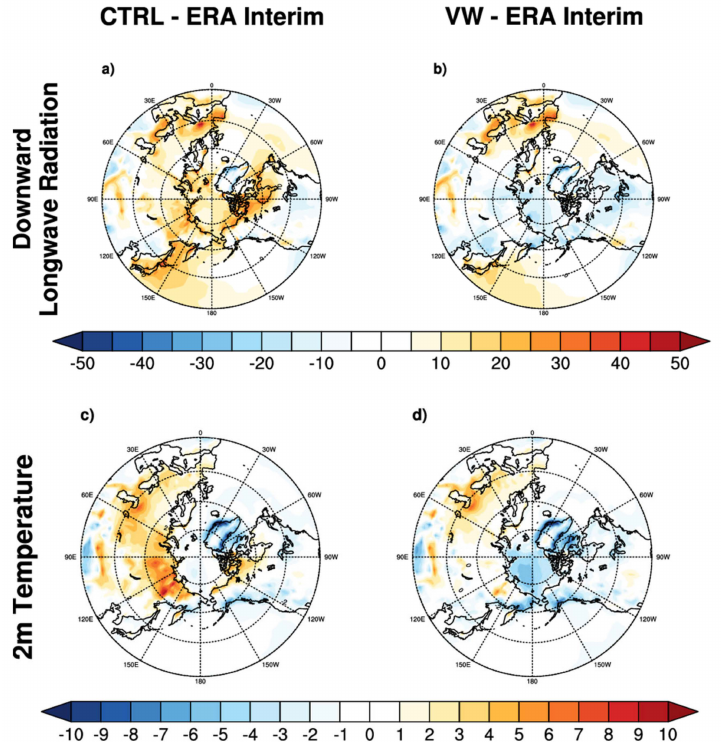
Figure 4. Biases of ( a , b ) DLR and ( c , d ) surface air temperature against ERA-interim reanalysis during winter obtained from ( left ) CTRL and ( right )